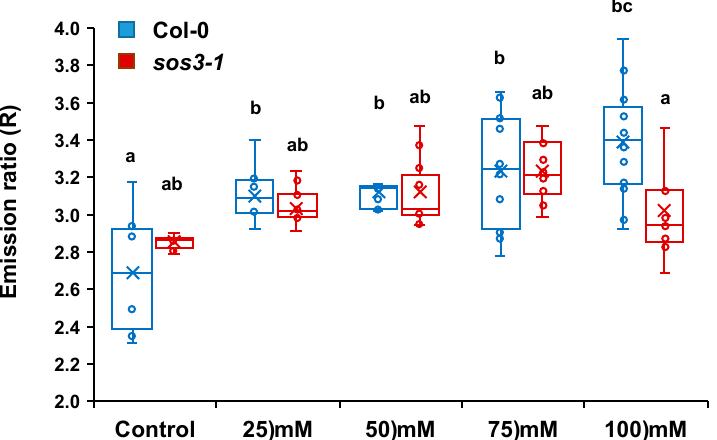
Figure 8. Cytosolic pH variations under salt stress reported by pHGFP-LTI6b in wild-type Col-0 and sos3 mutant seedlings. Seedlings expressing the pH-sensor pHGFP-LTI6b were treated with either LAK medium or the same medium supplemented with increasing concentrations of NaCl as indicated, and the variations of pHcyt were measured. Handling and measurements followed the One Shot per Root method. Fluorescence emission ratios (R) of pHGFP-LTI6b with or without treatment for each genotype are represented. The box plot shows individual data points. Outliers are not shown but were included for statistical analysis. The ”x” symbol represents the means. Different letters indicate groups with significantly different values according to Tukey HSD test at p < 0.05. The experiment was repeated twice with similar results.